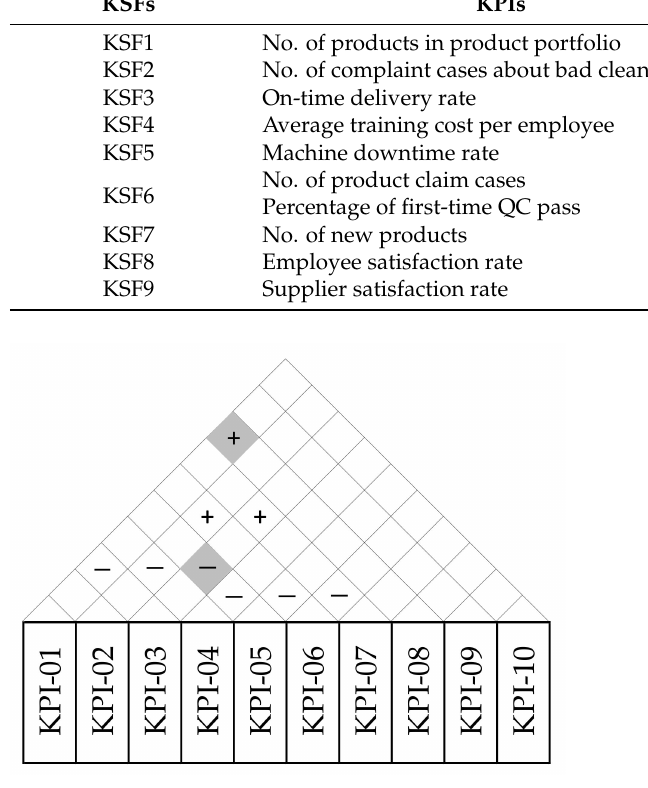
Figure 4. Correlations between KPIs of focused case.